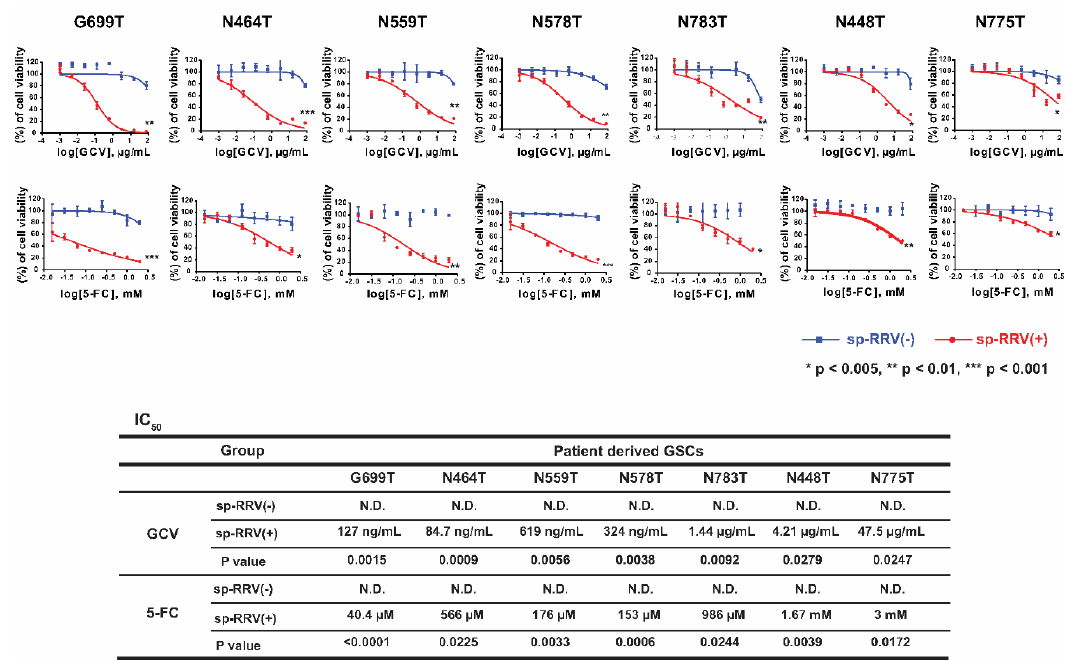
Figure 3. Different responses of seven patient-derived GSCs to GCV and 5-FC depend on the infectivity of spRRVe- sEF1α - TK and sRRVgp- sEF1α - CD viral vector systems. High-content screening for assessment of therapeutic efficacy of suicide genes ( TK and CD ) and two prodrugs (GCV, 0~78.125 µg/mL; 5-FC, 0~2 mM) in seven patient-derived GSCs treated with spRRVe- sEF1α - TK and sRRVgp- sEF1 α - CD was performed. Nonlinear regression analyses of dose-response curves (upper panel) and half maximal inhibitory concentration (IC 50 ) (lower panel) of seven patient-derived GSCs. Error bars represent standard deviation (SD). * p < 0.05, ** p < 0.01, *** p < 0.001.